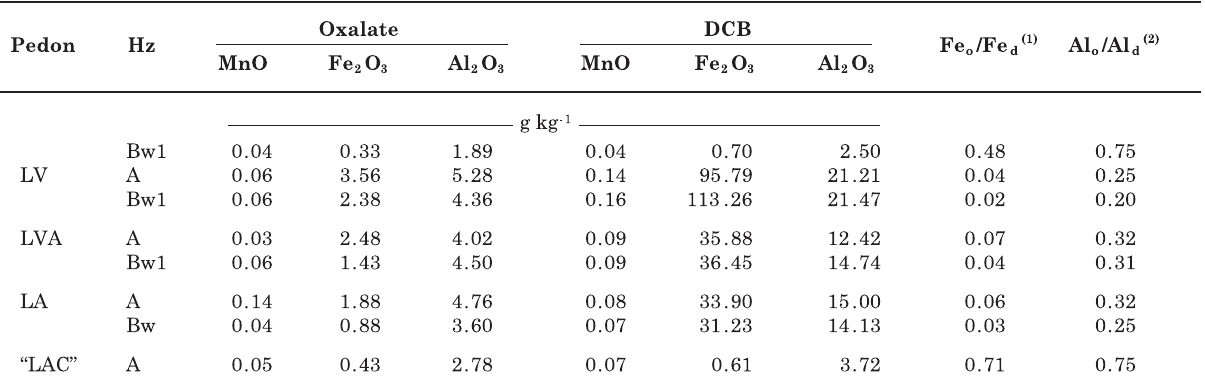
Table 6. Oxide contents based on oxalate and dionite-citrate-bicarbonate (DBC) extraction and their relation to the toposequence